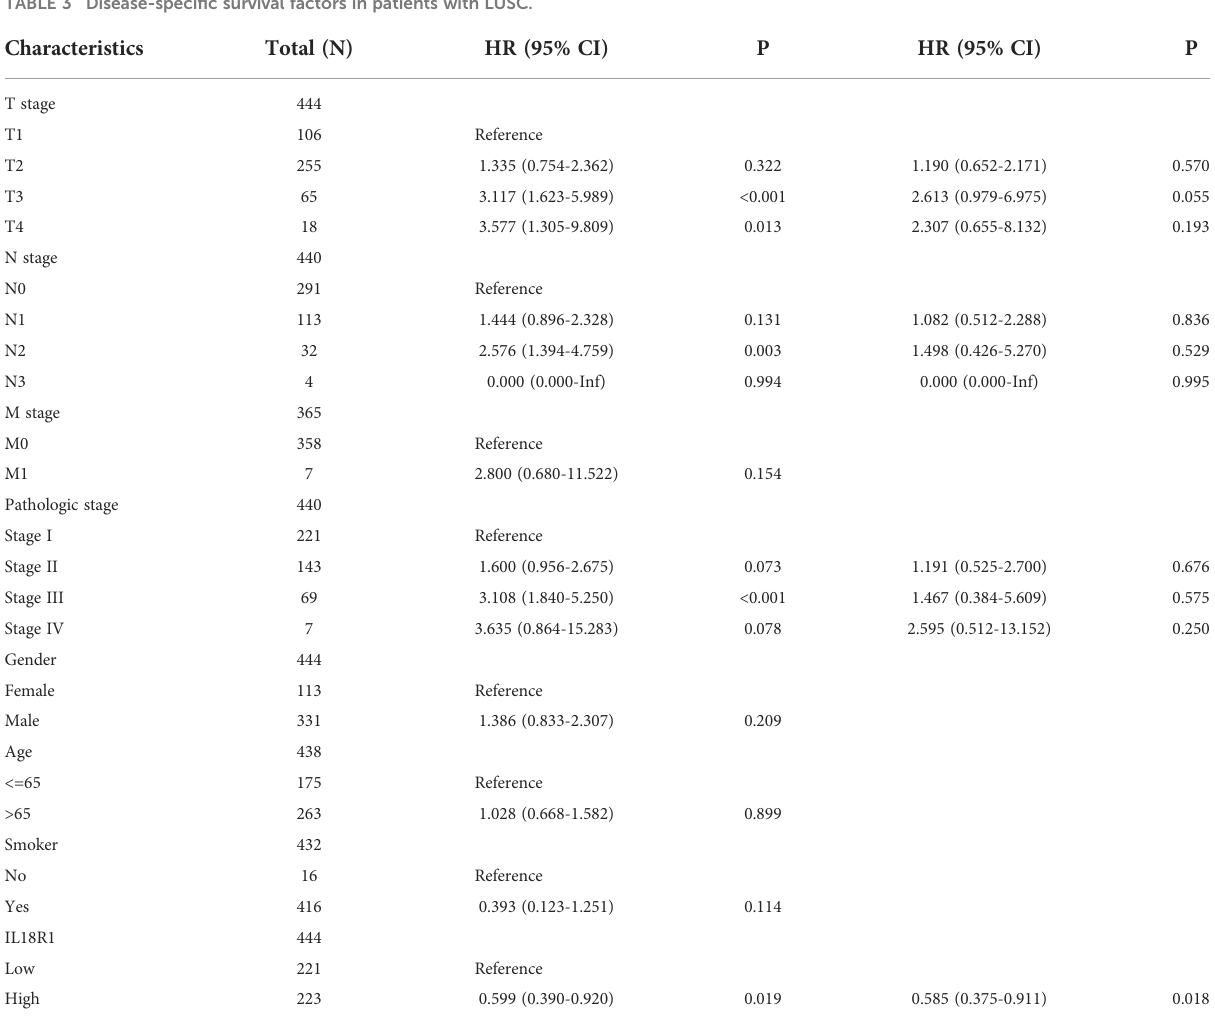
TABLE 3 Disease-speci fi c survival factors in patients with LUSC.